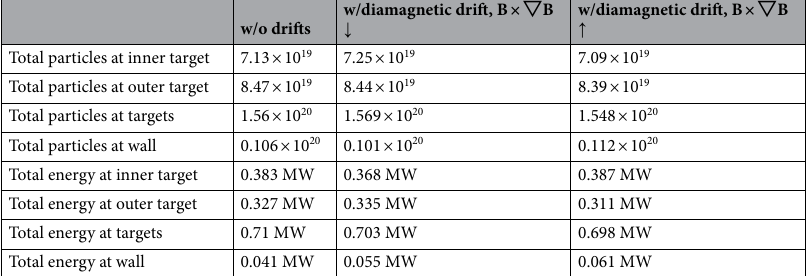
increases at the outer target while it only slightly increases at the inner target. The increases of particle and heat fluxes at both targets indicate that the E × B drift could induce net plasma flows from the upstream to the divertor targets. The right diagram in Fig. 5 shows the directions of E × B drift flows for tokamak plasmas with normal toroidal magnetic field. The black arrows represent the direction of poloidal E × B drift flow while the blue arrows represent the direction of radial E × B drift flow. The particles and energy are carried by the poloidal E × B drift flow from the upstream at low field side to the outer divertor region. Then these particles and energy are transferred to the inner divertor region by the radial E × B drift flow and the poloidal E × B drift flow in the PFR region. Some of the particles and energy return back to the upstream by the poloidal E × B drift flow at the high field side. The larger particle and heat fluxes at both targets after the inclusion of E × B drift indicate that the particles and energy across interface ➀ from the upstream at the low field side to the outer divertor region should be larger than those across interface ➄ from the inner divertor region to the upstream at high field side. The process of the DOIAs caused by E × B drift indicates that both the poloidal and the radial components of E × B drift should be necessary in impacting on the DOIAs of particle and heat fluxes. The significant differences